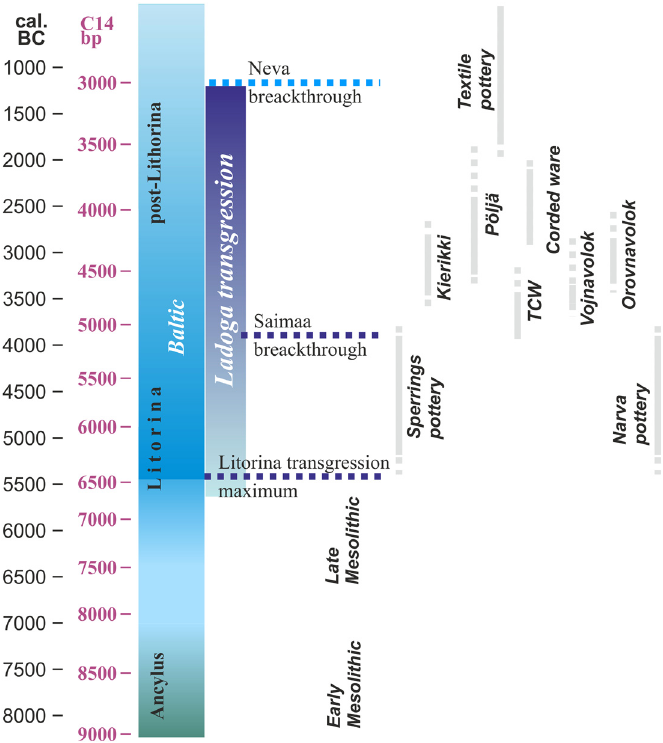
Figure 2: Chronology of the main cultural units and paleogeographic events in